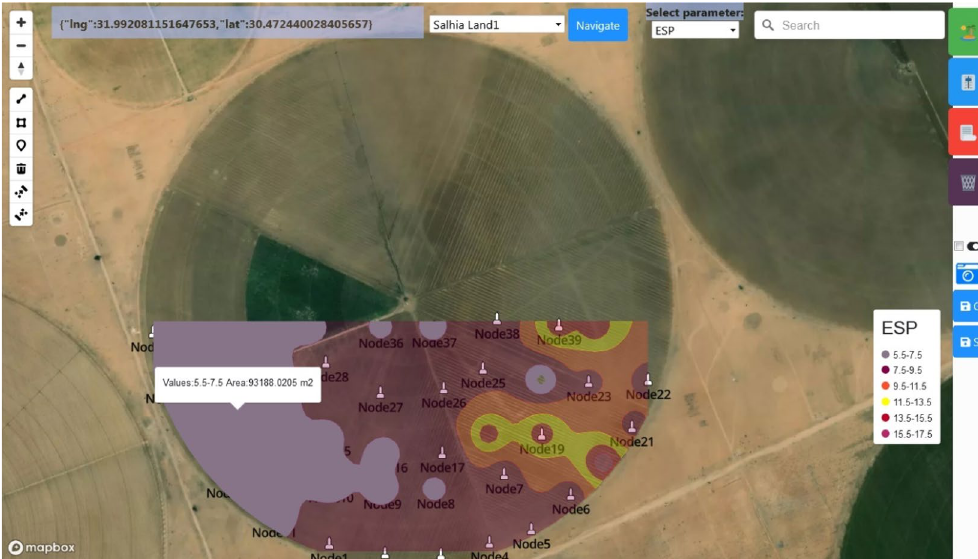
Figure 19. Gradual construction of MZ map while the nodes start sending data.